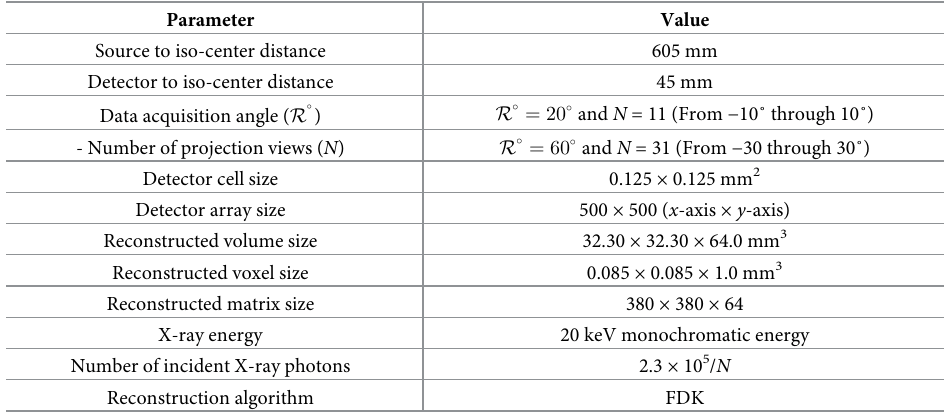
Table 2. Simulation parameters.